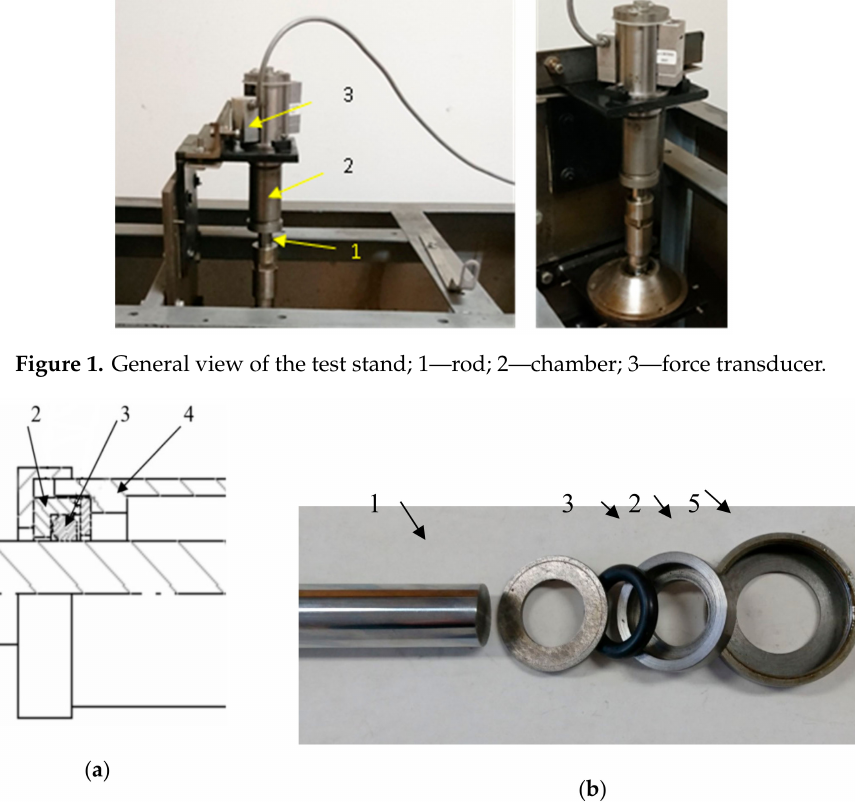
Figure 2. Elements of the test head ( a ) schematic cross-section of the test cell; ( b ) test cell elements; 1—rod; 2—housing; 3—seal; 4—chamber;